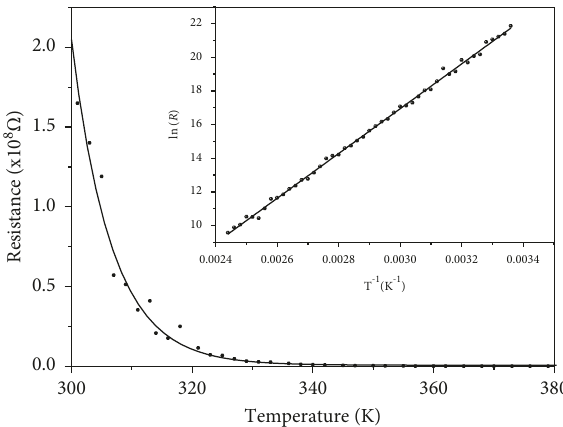
Figure 10: Resistance variation of MAPB with temperature.